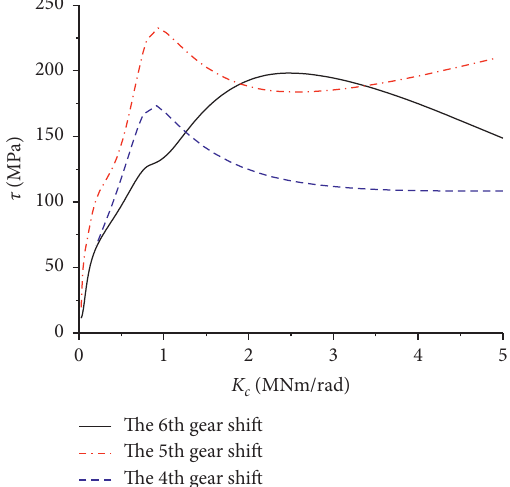
Figure 10: The max working stress of transmission